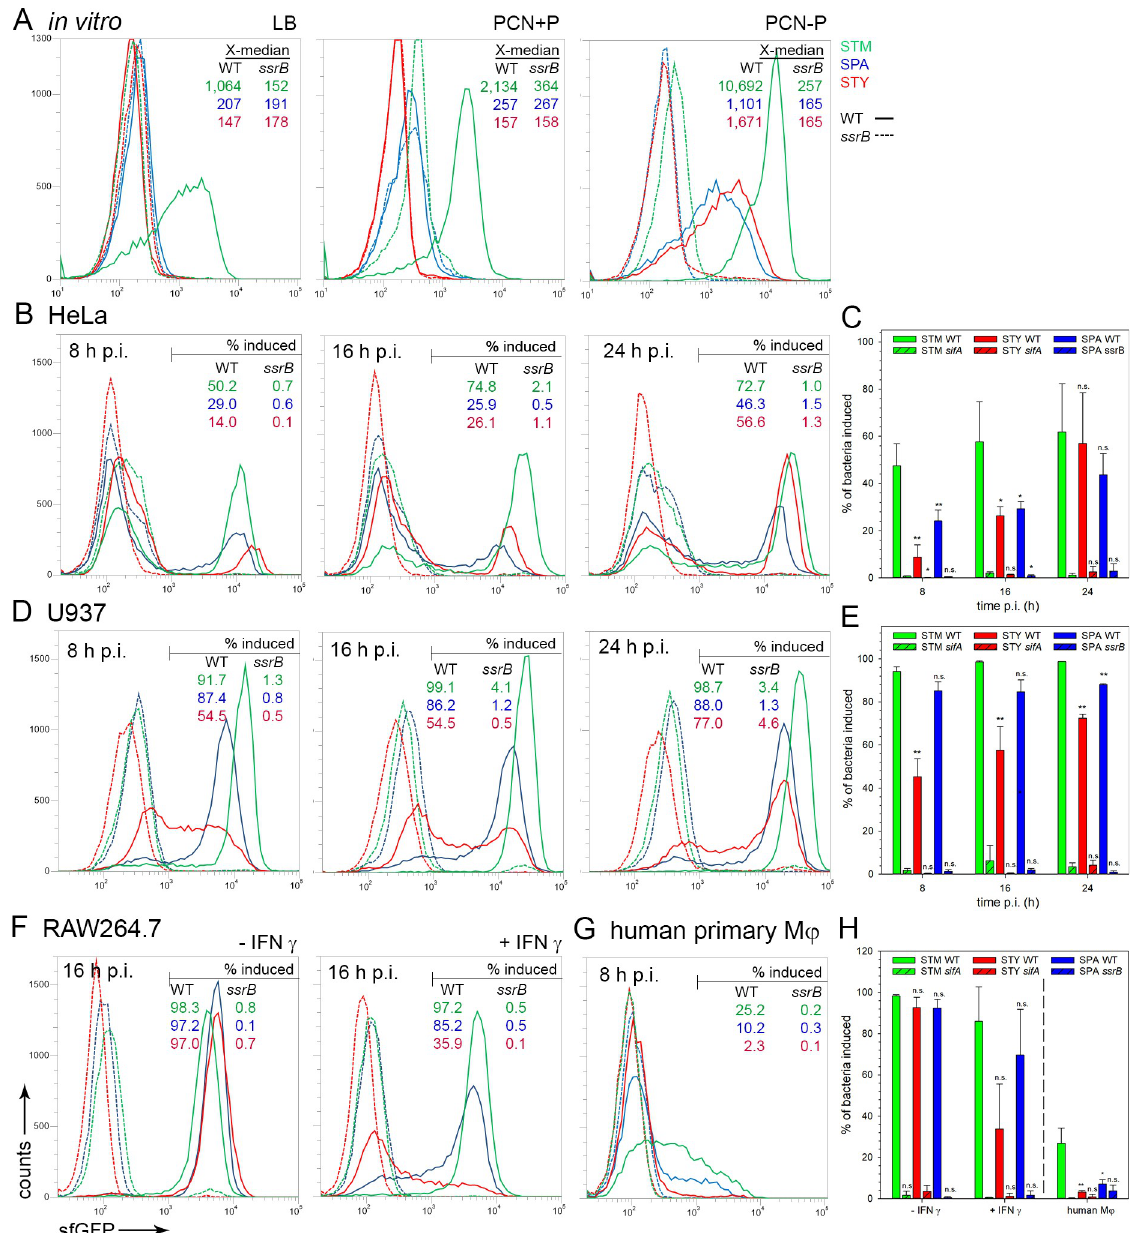
Fig 1. Expression of genes encoding the SPI2-T3SS by intracellular STM, SPA and STY. STM (green), SPA (blue), or STY (red) WT (solid lines) or ssrB mutant (dashed lines) strains were used, all harboring plasmid p3776 for constitutive expression of DsRed, and sfGFP under control of the ssaG promoter. A ) Various strains were grown in non-inducing PCN medium (PCN pH 7.4, 25 mM P i ), or inducing PCN medium (PCN pH 5.8, 0.4 mM P i ). After culture o/n with aeration by rotation at 60 rpm in a roller drum, aliquots of cultures were fixed, and bacteria were analyzed by flow cytometry (FC). The X-median values for the sfGFP-positive bacteria are indicated. Various strains were used to infect HeLa cells ( B, C ), U937 macrophages ( D, E ), RAW264.7 macrophages ( F, H ) without or with activation by γ -interferon (IFN- γ ), or human primary macrophages ( G ). At 8 h, 16 h, or 24 h p.i. as indicated, host cells were lysed in order to release bacteria. For FC, at least 10,000 bacteria-sized particles with DsRed fluorescence were gated and GFP intensities were quantified. The percentage of intracellular bacteria with induction of P ::sfGFP is indicated for WT and Δ ssrB strains. The data sets in A ), B ), D ), F) , and G ) show data representative ssaG for three independent experiments with similar outcome. Means and standard deviations of three biological replicates of infection of HeLa ( C ), U937 ( E ), or RAW264.7 cells ( H ) are shown. Statistical analysis was performed by One-way ANOVA and are indicated as follows: n.s., not significant; � , P < 0.05; �� , P < 0.01; ��� , P < 0.001.